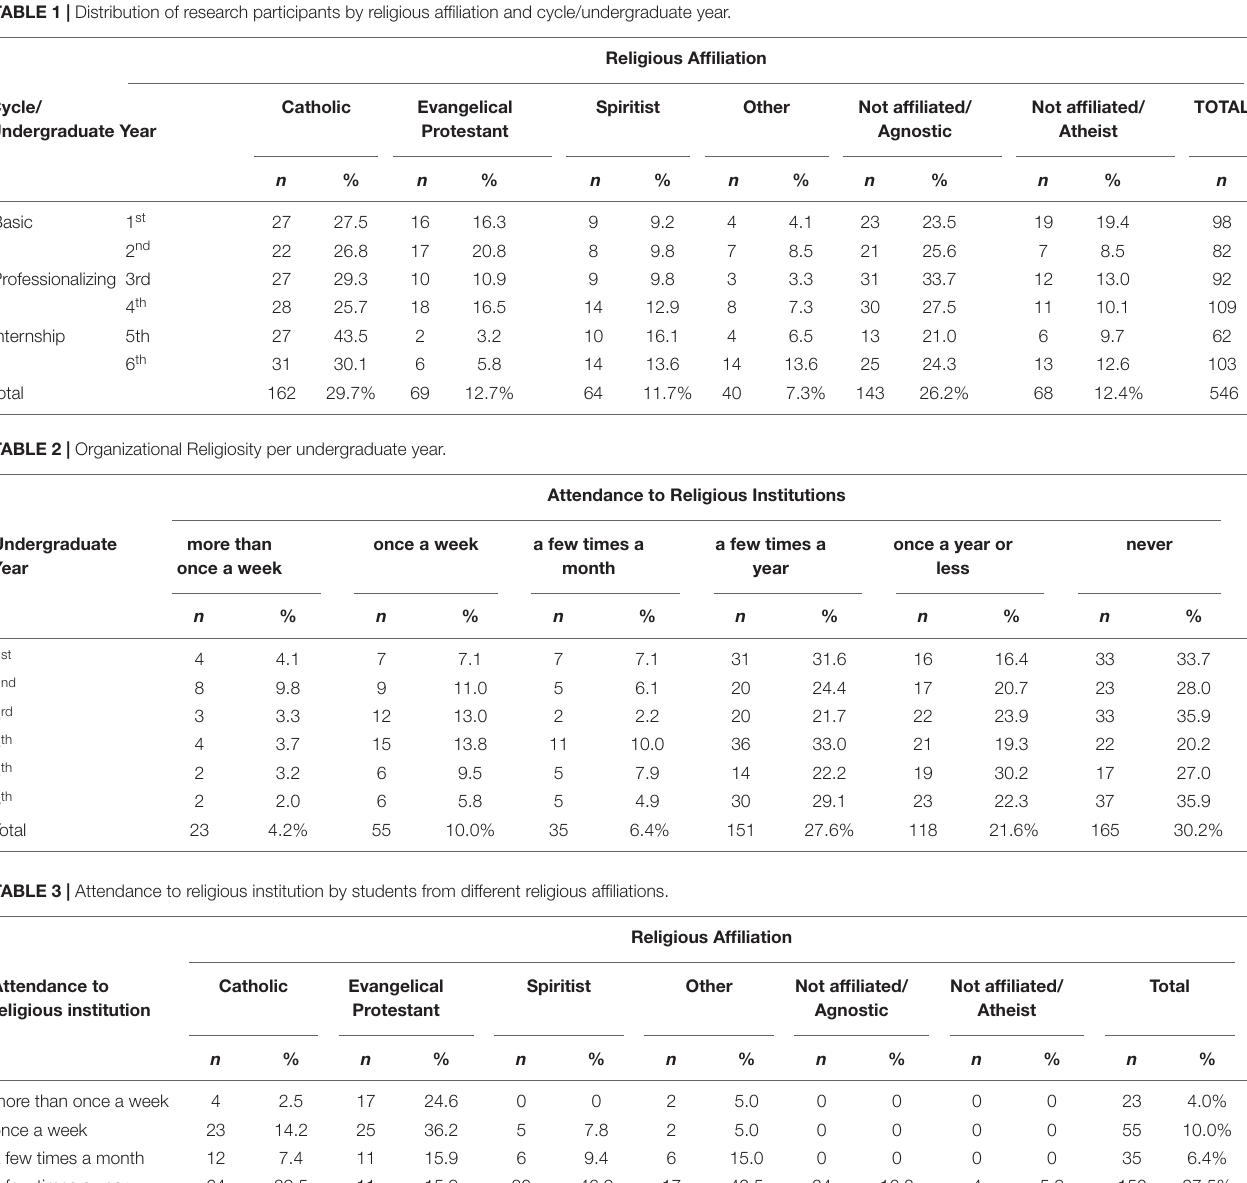
TABLE 1 | Distribution of research participants by religious affiliation and cycle/undergraduate year.